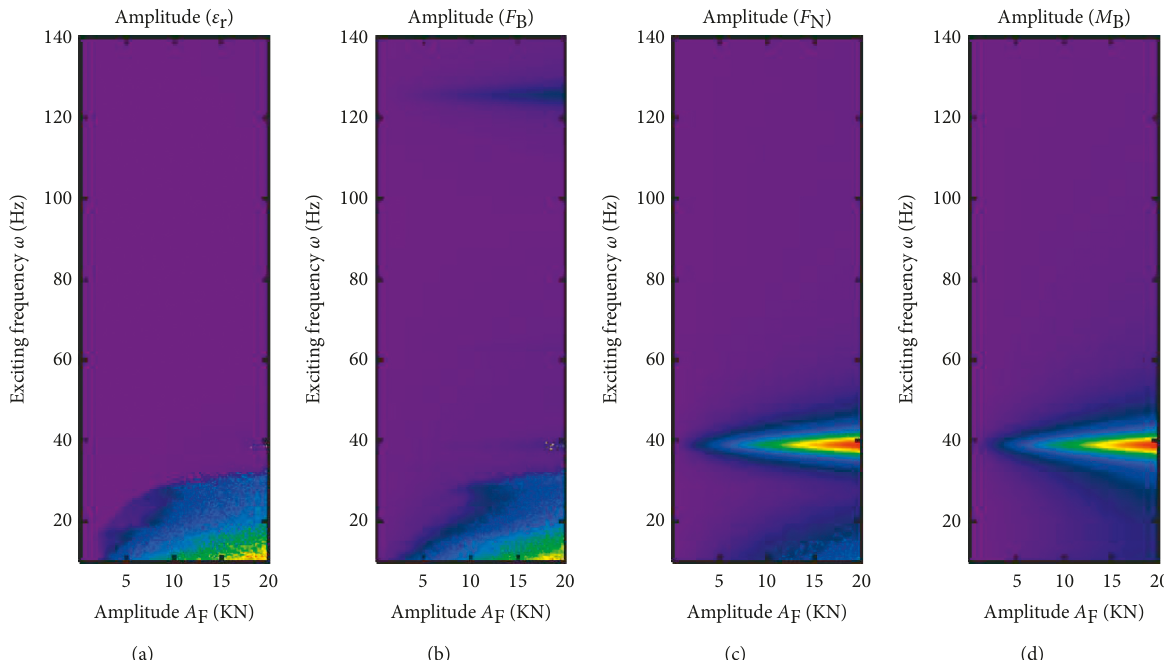
Figure 4: Amplitude of the roller ring relative displacement and the tested shaft loads with respect to the shaker exciting frequency and